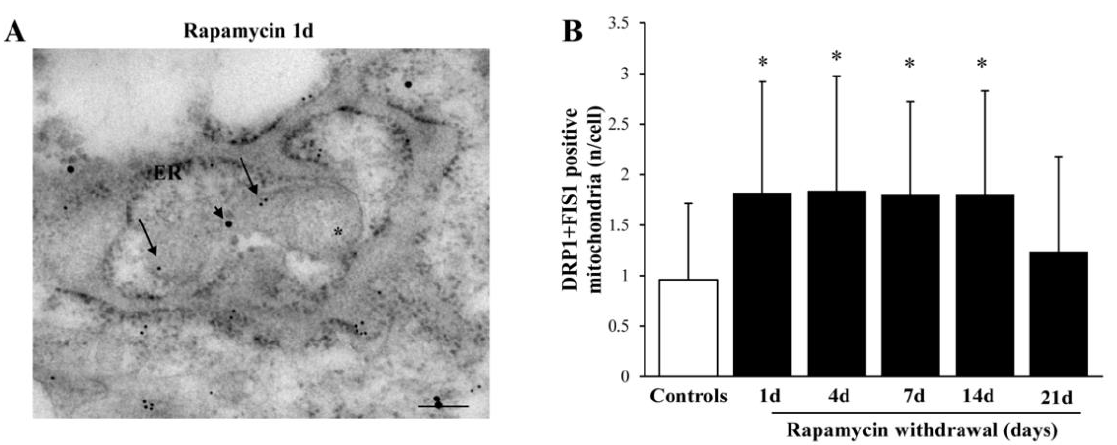
Figure 13. Rapamycin increases the combination of fission markers FIS1 and DRP1. ( A ) Representative mitochondrion double stained for FIS1 and DRP1 immuno-gold particles (20 nM, arrowhead, and 10 nM, arrows respectively) following 1 d rapamycin withdrawal. Graph ( B ) reports FIS1+DRP1-positive mitochondria. Values reported in the graph correspond to the mean ± SD. Mitochondria were counted in 50 cells per group. * p ≤ 0.05 compared with controls. Scale Bar = 0.25 µ m, Asterisk (*) = mitochondria, ER = endoplasmic